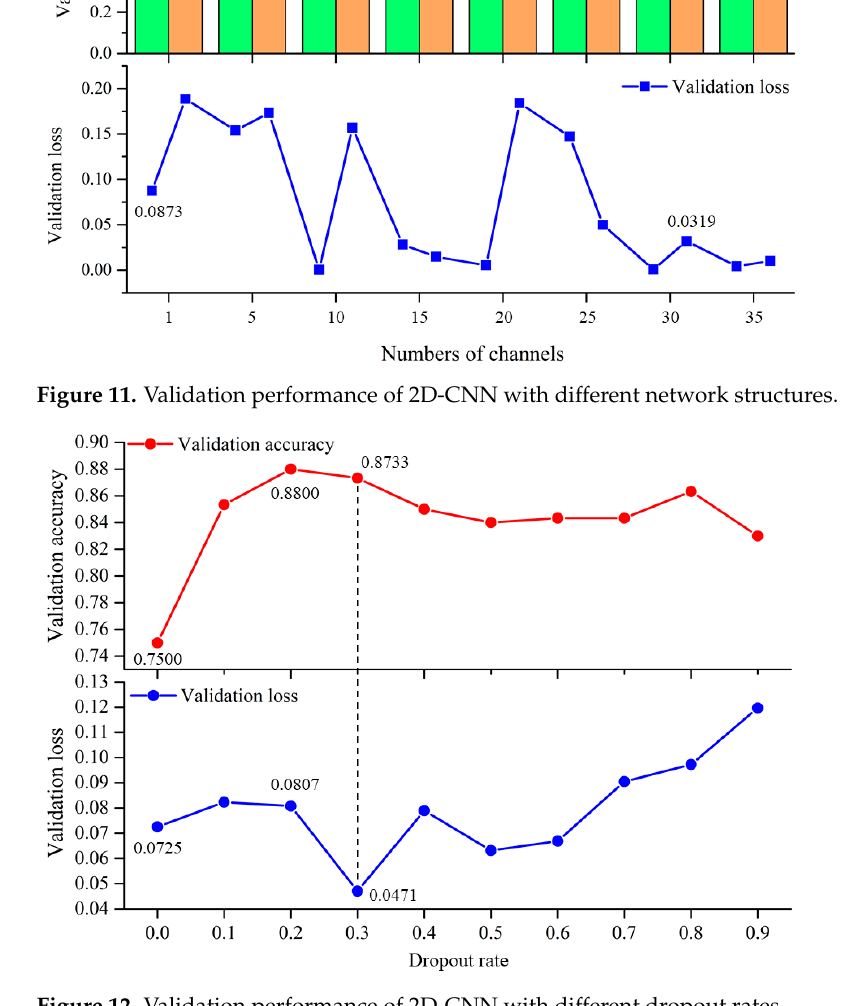
Figure 12. Validation performance of 2D-CNN with different dropout rates. Table 5. Confusion matrix and accuracy of 2D-CNN identification model for three